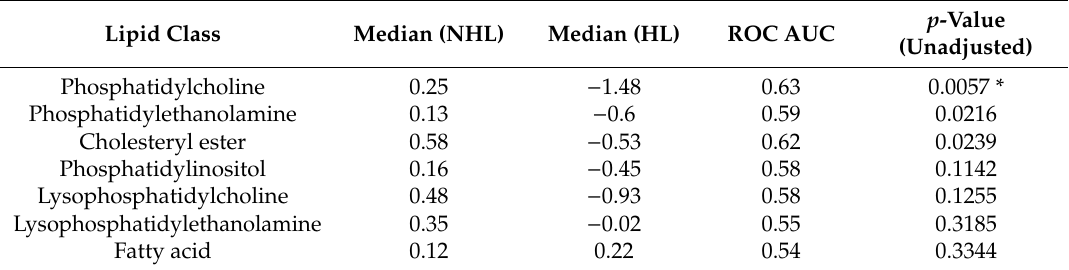
Table 4. Table of lipid classes derived from sets 4 and 23 from Barupal et al. (2019) and their performance in distinguishing HL from NHL subjects. Unadjusted p -values that survive the Bonferroni correction ( < 0.05) are noted with